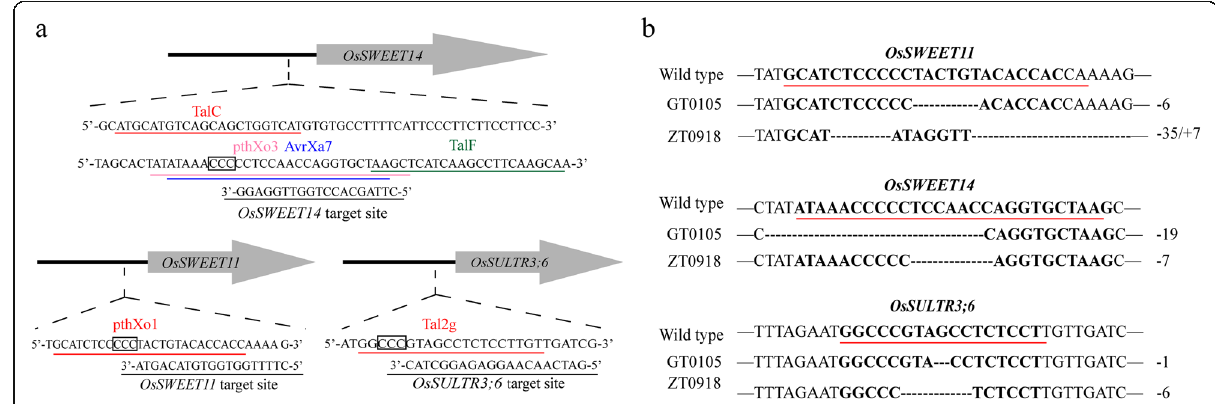
Fig. 1 CRISPR-mediated editing of the susceptibility genes ’ EBEs in rice. a, Schematic presentation of the target sites. The underlined sequences are the target sites. The sequences with black boxes represent the protospacer adjacent motif (PAM). b, Genotypes of the EBEs. Wild type represents the genotypes of Guihong 1 and Zhonghua 11. The sequences underlined in red are TALE binding sites. Deletions are indicated as dashes; the sign − /+ stands for deletion/ insertion; the number represents the number of deletion/insertion bases. The genotypes of OsSWEET11 ’ s EBE in ZT0918 is shown in Supplemental Fig.